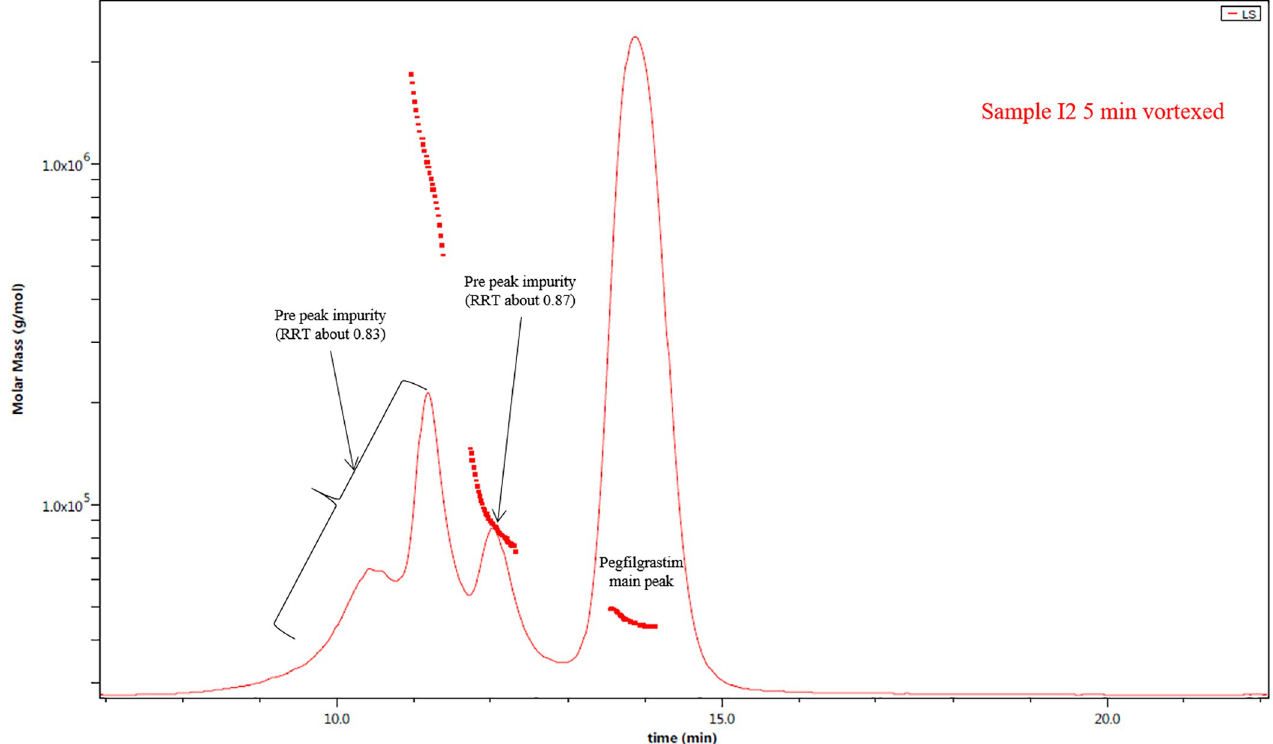
Fig 15. Light scattering profile of vortexed INTP5 (molar mass vs.